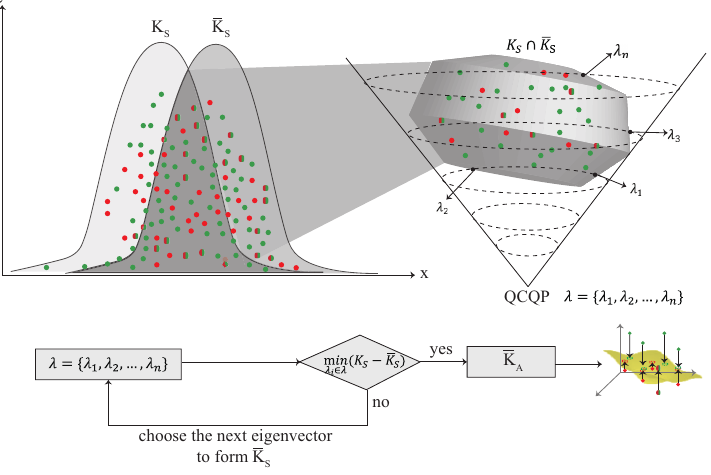
Figure 10. The multi-kernel optimization phase.